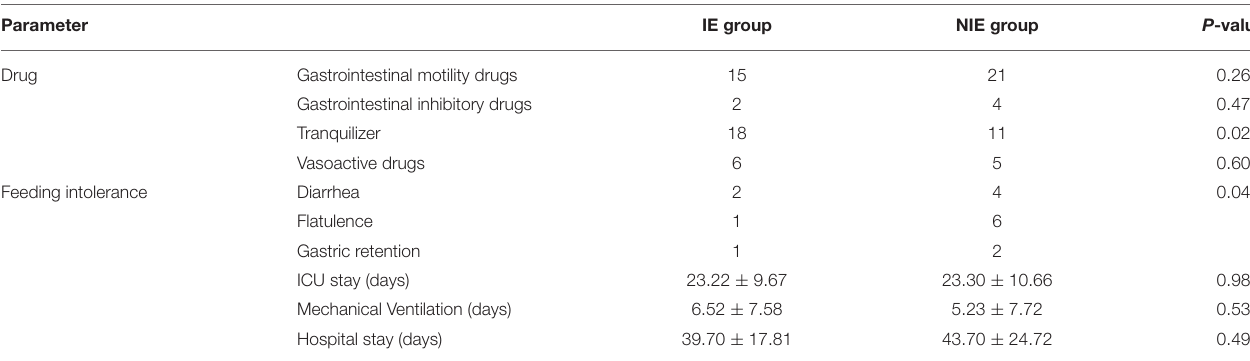
TABLE 4 | Clinical outcome features after